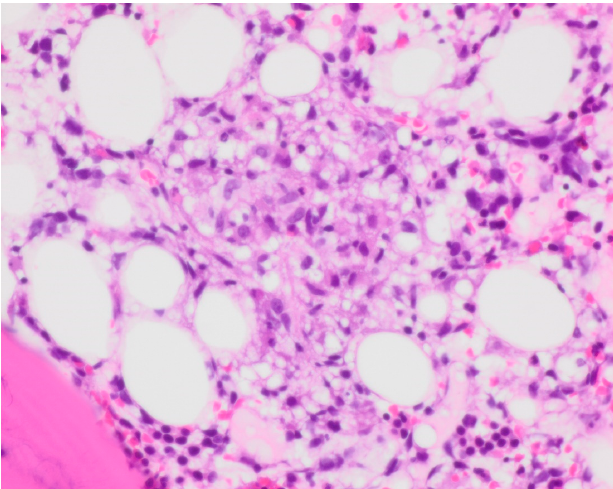
Figure 2. Core biopsy, showing loose aggregates of macrophages next to bone. Hemotoxylin and Eosin (H and E) staining with 40× objective magnification.